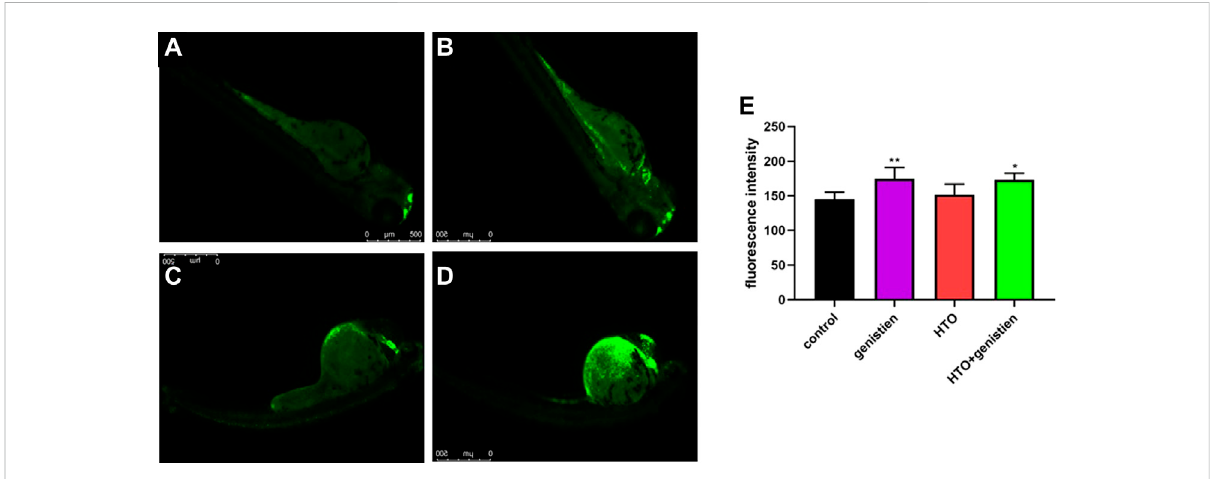
FIGURE 5 Apoptosis in 96 hpf zebra fi sh larvae. (A) control group; (B) 3.7*10 2 Bq/ml HTO group; (C) 1.4 mg/L genistein group; (D) 3.7*10 2 Bq/ml HTO+1.4 mg/L genistein group; (E) Fluorescence intensity analysis. 10 samples were taken from each parallel samples of each experimental group. * p < 0.05, ** p <